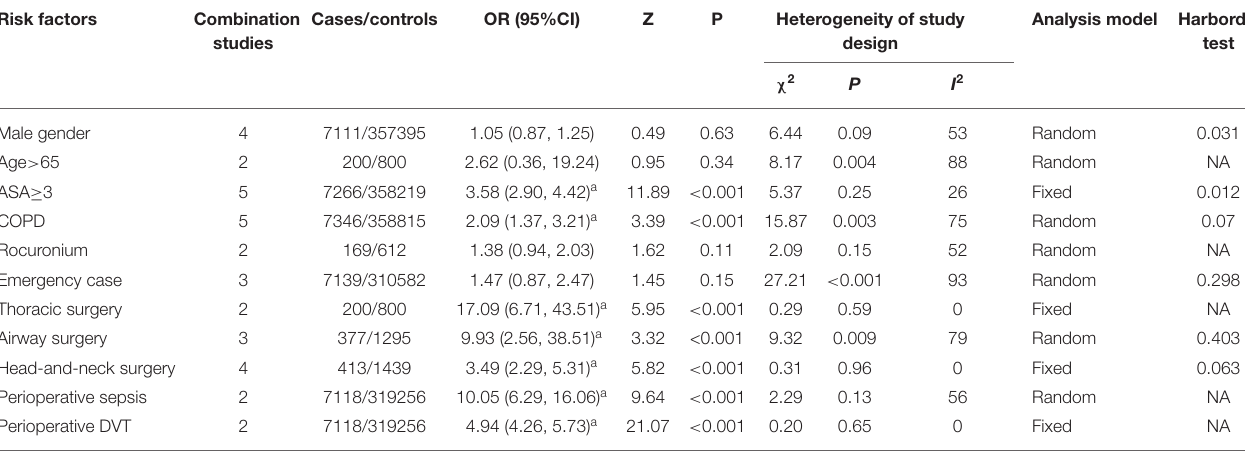
TABLE 4 | Meta-analysis of risk factors of POR in patients after